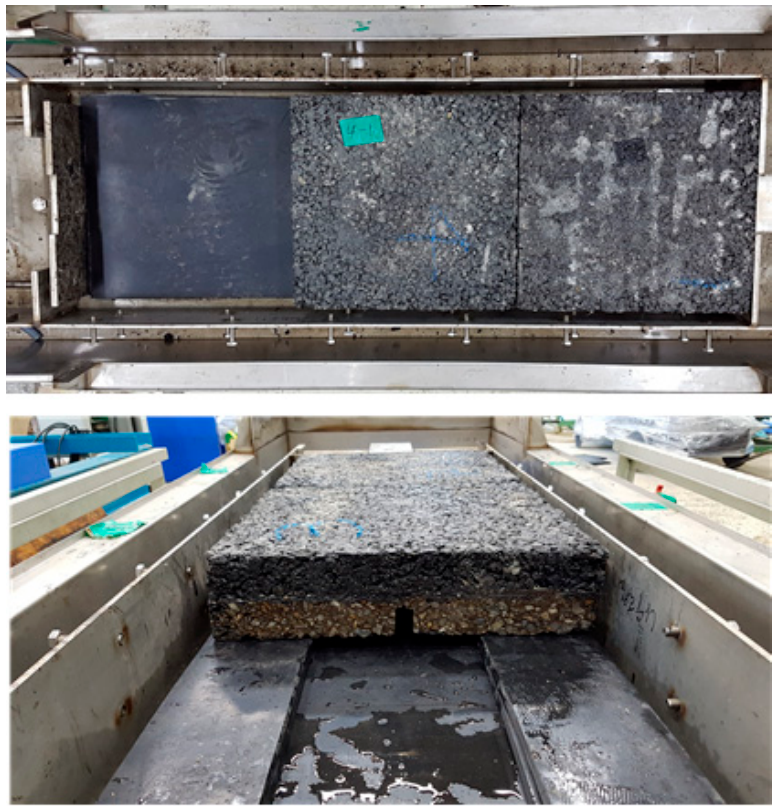
Figure 3. Specimen installation.